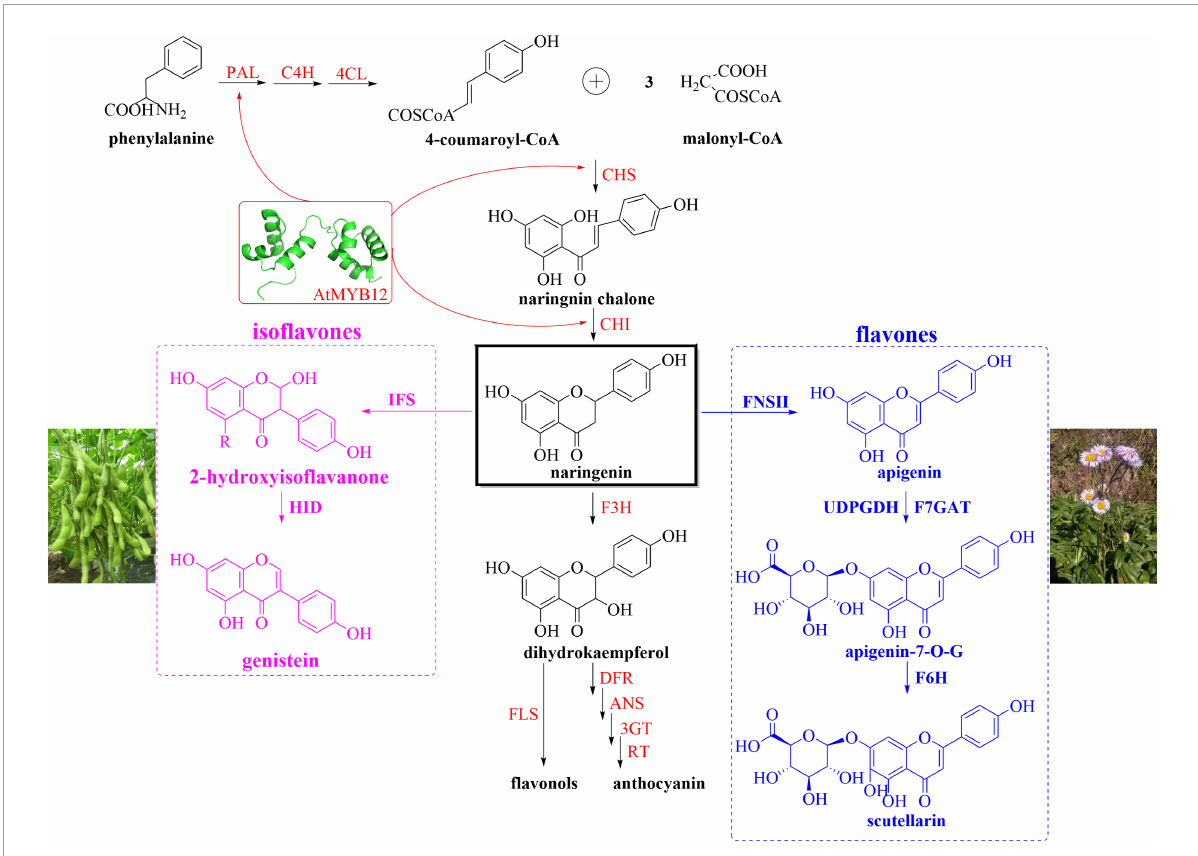
FIGURE4 Schematic overview of the genistein and scutellarin biosynthetic pathways in N . benthamiana . A simplified representation of flavonoids biosynthesis in N . benthamiana shows key intermediates (black) and enzymes (red). Naringenin (black box), as a crucial node, enters different metabolic pathways catalyzed by different heterologous enzymes. The enzymes in pink box (isoflavones) and blue box (flavones) are derived from soybean and E. breviscapus , respectively. The red arrow represents partial genes that can be activated by AtMYB12. PAL, phenylalanine ammonia lyase; CoA, coenzyme A; C4H, cinnamate 4-hydroxylase; 4CL, 4-hydroxycinnamoyl CoA ligase; CHS, chalcone synthase; CHI, chalcone isomerase; IFS, isoflavone synthase; HID, hydroxyisoflavanone dehydratase; F3H, flavanone-3-hydroxylase; DFR, dihydroflavonol reductase; ANS, anthocyanidin synthase; RT, rhamnosyl transferase; 3GT, flavonol-3-glucosyltransferase; FLS, flavonol synthase; apigenin-7-O-G, apigenin-7-O-glucuronide; FNSII, flavone synthase II; UDPGDH, UDP-glucose dehydrogenase; F7GAT, flavonoid-7-O-glucuronosyltransferase; F6H,